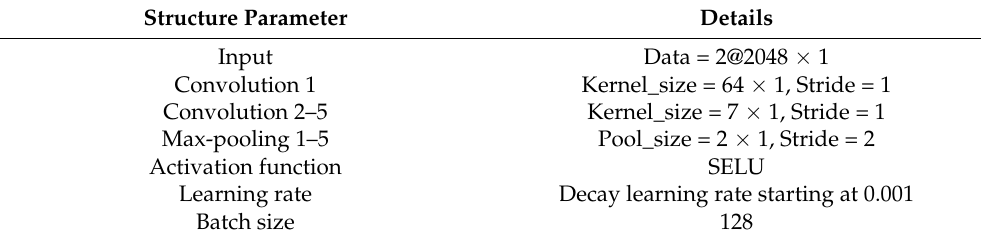
Table 2. The main structural parameters of the MC-DCNN model.